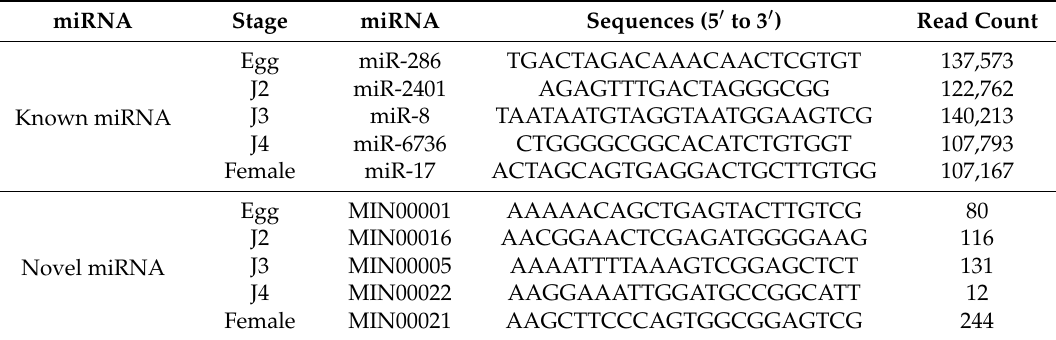
Table 8. Highly expressed stage-specific miRNAs of M. incognita .